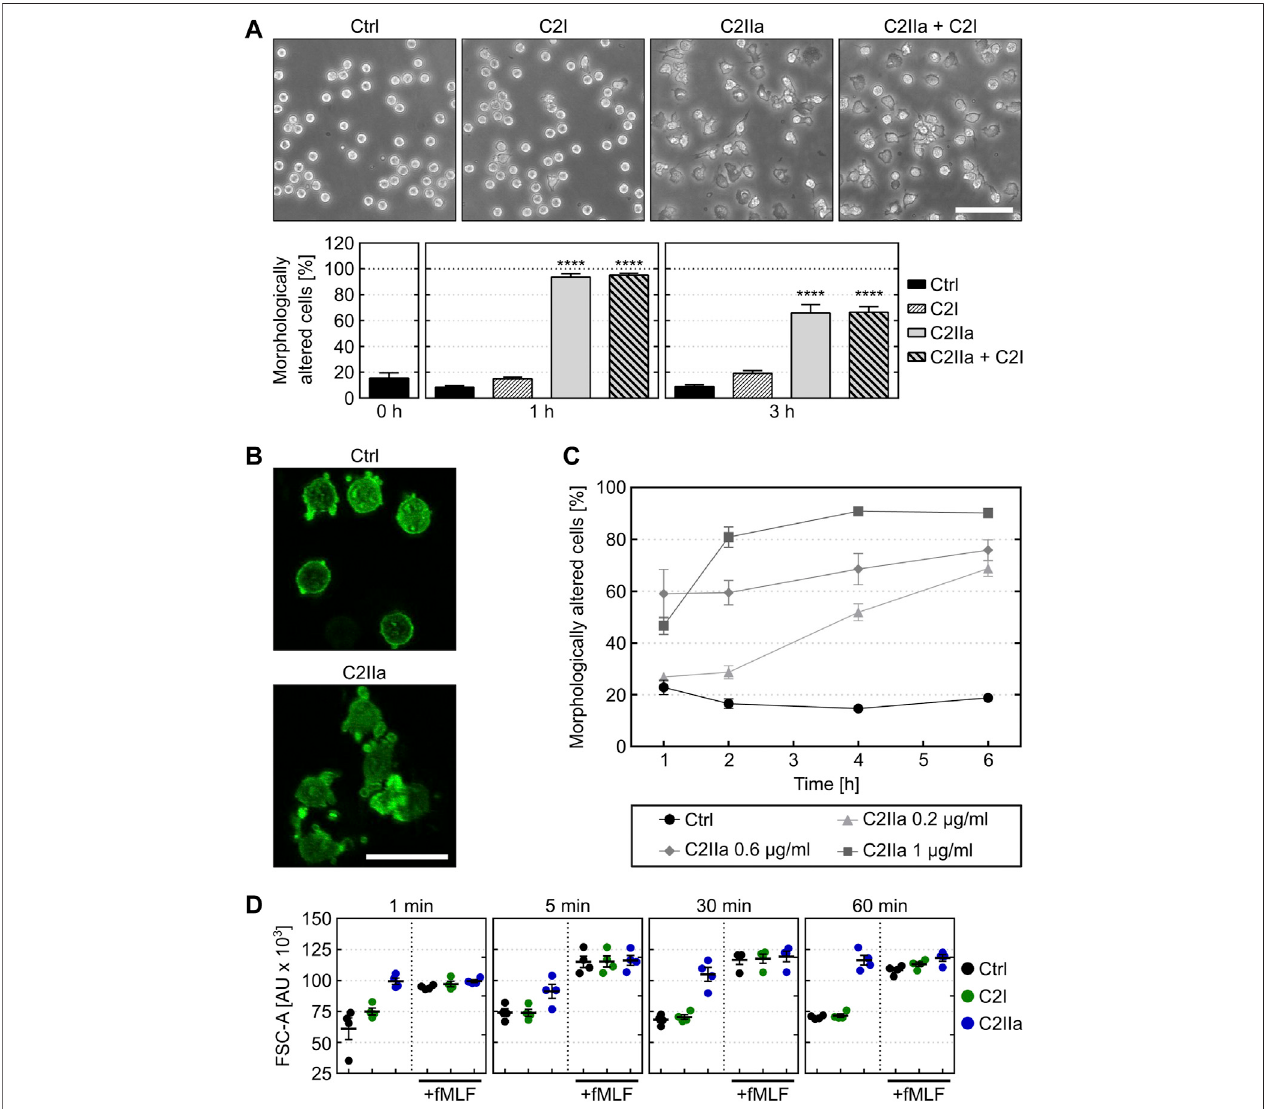
FIGURE 1 | Effect of C2IIa on the morphology of primary human neutrophils (PMNs) ex vivo. (A) Upper panel: Representative pictures show the morphology of PMNs incubated for 3 h at 37 ° C with C2IIa (2 μ g/ml), C2I (1 μ g/ml), both components (2 μ g/ml C2IIa + 1 μ g/ml C2I) or without any protein as control (Ctrl). Scale bar: 100 µm. Lower panel: Quantitative evaluation of morphologically altered PMNs after 1 and 3 h treatment at 37 ° C with C2IIa (2 μ g/ml), C2I (1 μ g/ml), both components (2 μ g/ml C2IIa + 1 μ g/ml C2I) or without any protein as control (Ctrl). Data show the results of 5 independent experiments, each with 3 technical replicates. Values represent the mean ± SEM (n = 15). Signi fi cance was tested against the untreated control (Ctrl) at each individual respective time point using Kruskal – Wallis test with Dunn ’ scorrectionformultiplecomparison (**** p < 0.0001).Untreatedcells(Ctrl)didnotchangetheirmorphologyoverthetimecourseoftheexperiment.Attimepoint0, all cells showed the same morphology as the untreated control cells when the respective proteins were applied to the individual groups of the cells. (B) Representative picturesofactin-stained(phalloidin-FITC)PMNsafter3 hincubationat37 ° Cwith1 μ g/mlC2IIaorwithoutanyprotein(Ctrl).Scalebar:25 µm. (C) Quantitativeanalysisof morphologicalchangesovertimeofPMNstreatedwithdifferentconcentrationsofC2IIaornoC2IIa(Ctrl).Datashowtheresultsof3independentexperiments,eachwith 3technicalreplicates.Valuesrepresentthemean±SEM(n=9). (D) FlowcytometrycanalysisofPMNsaftertreatmentwithC2IIa,C2IorPBSforcontrol(Ctrl).Changeof FSC was measured as surrogate for PMN cell size after incubation with C2I (1 μ g/ml) or C2IIa (2 μ g/ml). In parallel, PMNs were incubated with C2I (1 μ g/ml) or C2IIa (2 μ g/ml) in the presence of fMLF (1 µM), a chemoattractant peptide. PMNs from the same tube were analyzed after 1, 5, 30, and 60 min. Data is given as mean of four independent experiments ± SEM (n =